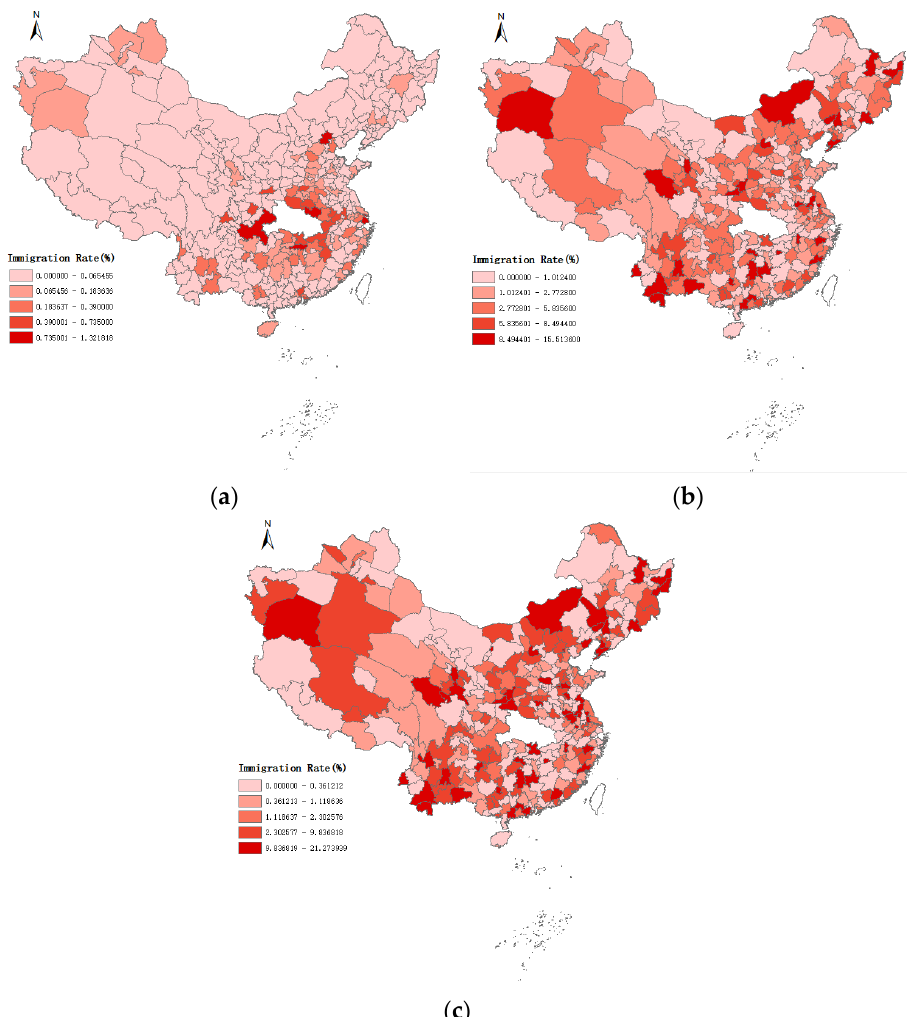
Figure 6. Population migration rates from Wuhan and Hubei Province to other prefecture-level cities (excluding Hong Kong, Macao, and Taiwan), respectively. ( a ) Migration rates from Wuhan to other prefecture-level cities before Wuhan’s closure of all channels; ( b ) migration rates from Hubei Province to other prefecture-level cities before Spring Festival; ( c ) migration rates from Hubei Province to other prefecture-level cities after Spring Festival.